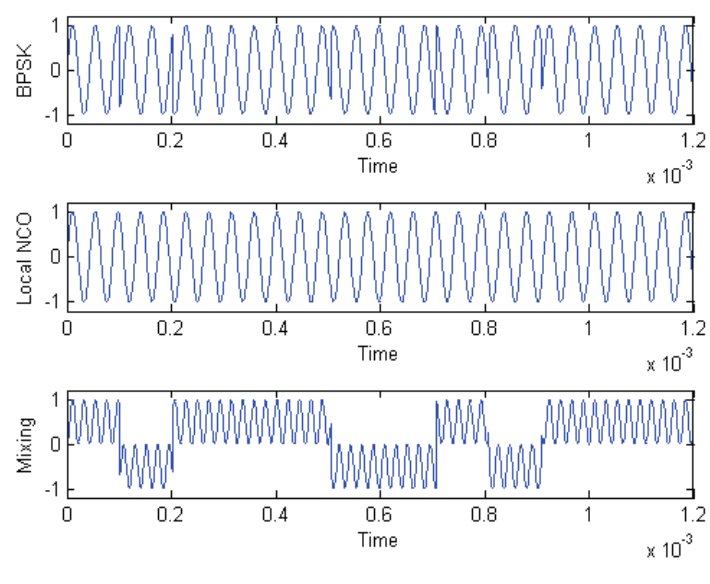
Figure 16. Simulation result of demodulated waveform.